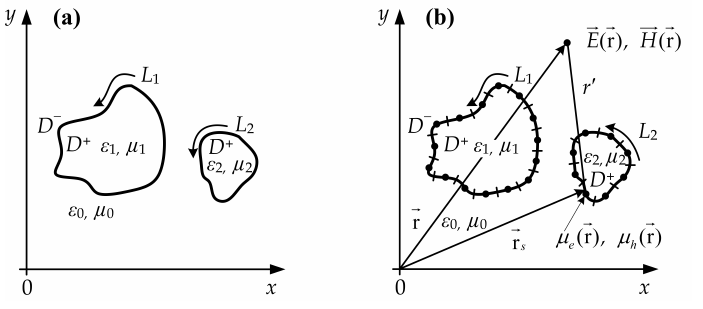
Figure 3. Arbitrary geometry of a waveguide ( a ) cross–section and ( b )